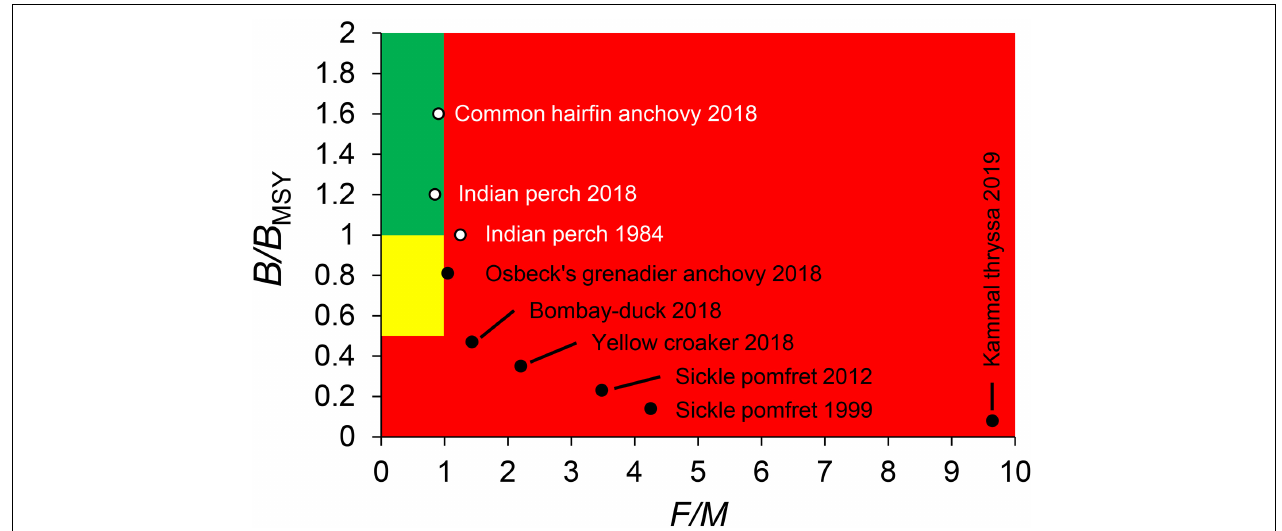
FIGURE 7 | The scatter plot of B / B MSY and F / M for the nine LBB models of seven fish stocks in question. Red area, stocks that are being overfished or are outside of safe biological limits; yellow area, recovering stocks; green area, stocks subject to sustainable fishing pressure and of a healthy stock biomass. White dots mean L mean / L opt > 0.9.